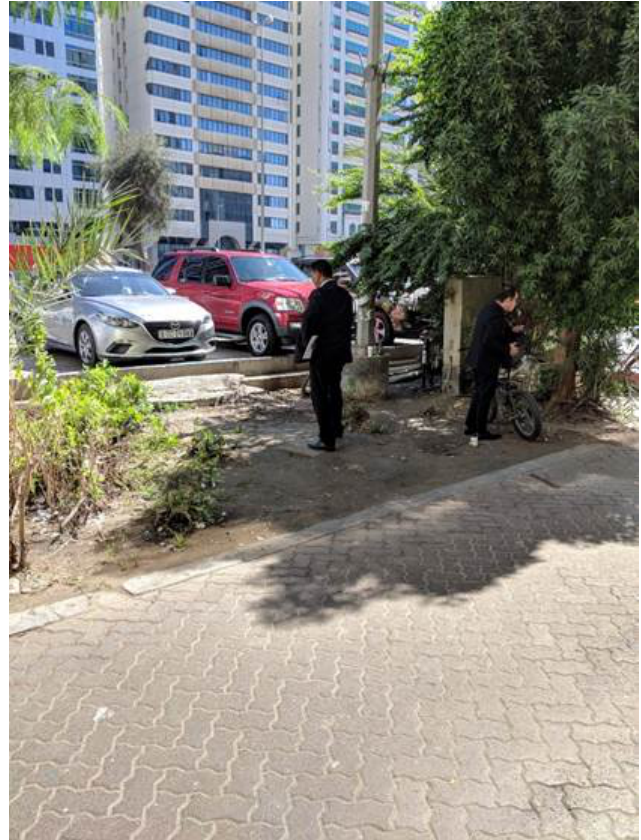
Enjoying a cup of tea and a cigarette in the shade after lunch (Source: